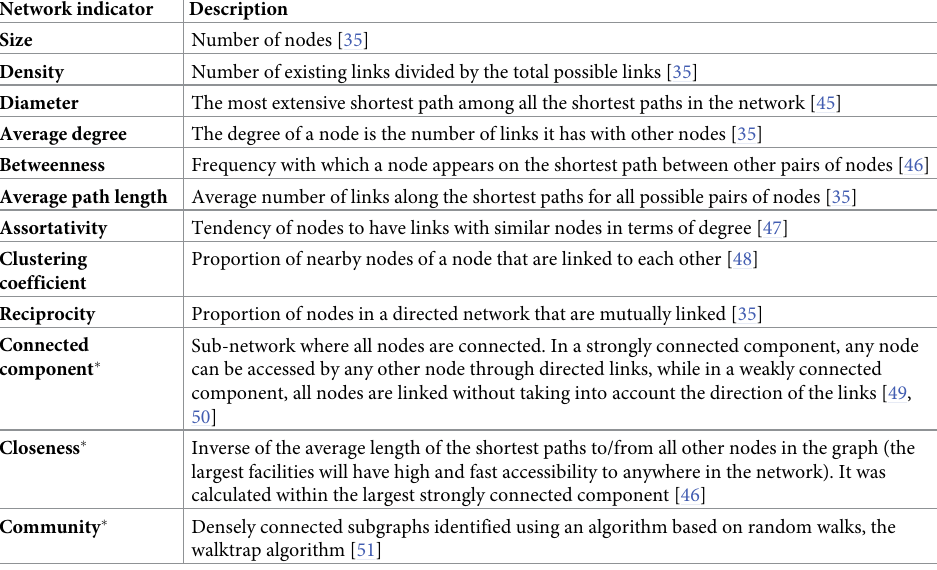
Table 1. Description of general network indicators calculated in this study. � Calculated for the global and annual networks. Network